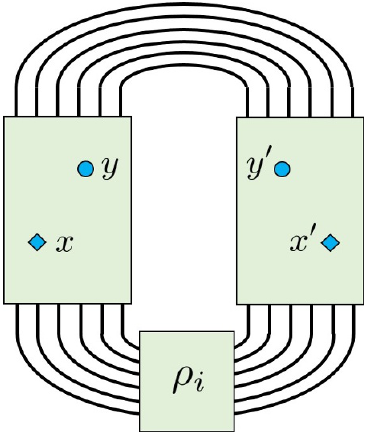
Figure 7 . A spacetime state with initial state (cid:26) i . Two spacetime points x and y are designated, along with their mirror copies x 0 and y 0